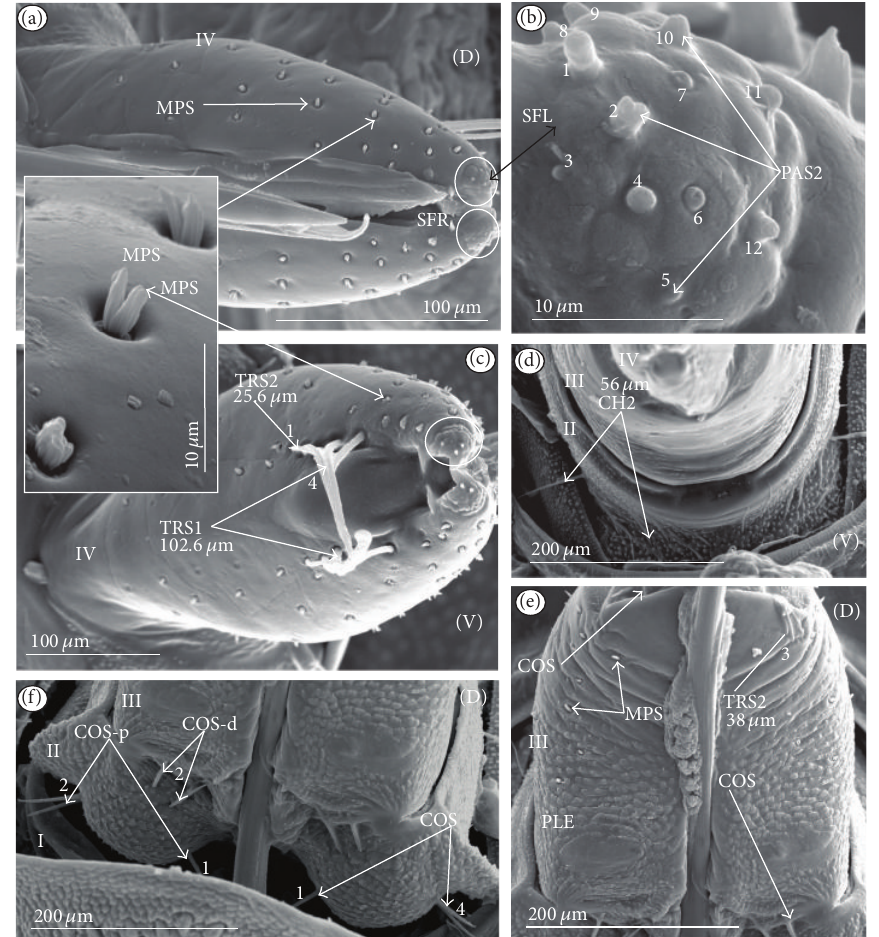
Figure 21: Types and sizes of the sensilla of the Naucoridae: Limnocorinae ( Limnocoris lutzi ). (a) MPS are numerous and distributed in rows over the IV segment (dorsal view). (b) PAS (no. 1–12) are located on the labial tip (SFL). (c) TRS1 (four) and TRS2 (one) are situated on the ventral side (V) in one row near the apex of the IV segment; MPS are also numerous ventrally and distributed in rows. (d) CH2 are less numerous and sparsely distributed over the ventral surface of the III and II segments. (e) TRS2 (three) are distributed separately on the distal edge of the III segment, MPS are less numerous and sparsely situated on the dorsal surface of the III segment, COS are situated on the IV segment, and on the surface of the III segment there are numerous, characteristic plates (generally unidentified structures, PLE-type). (f) Two (or four) COS-p are visible on the external distal edge of the II segment, and one is situated internally closer to the labial groove (Figure 21(f)). Two the COS-d are situated in the middle of the II segment on the proximal